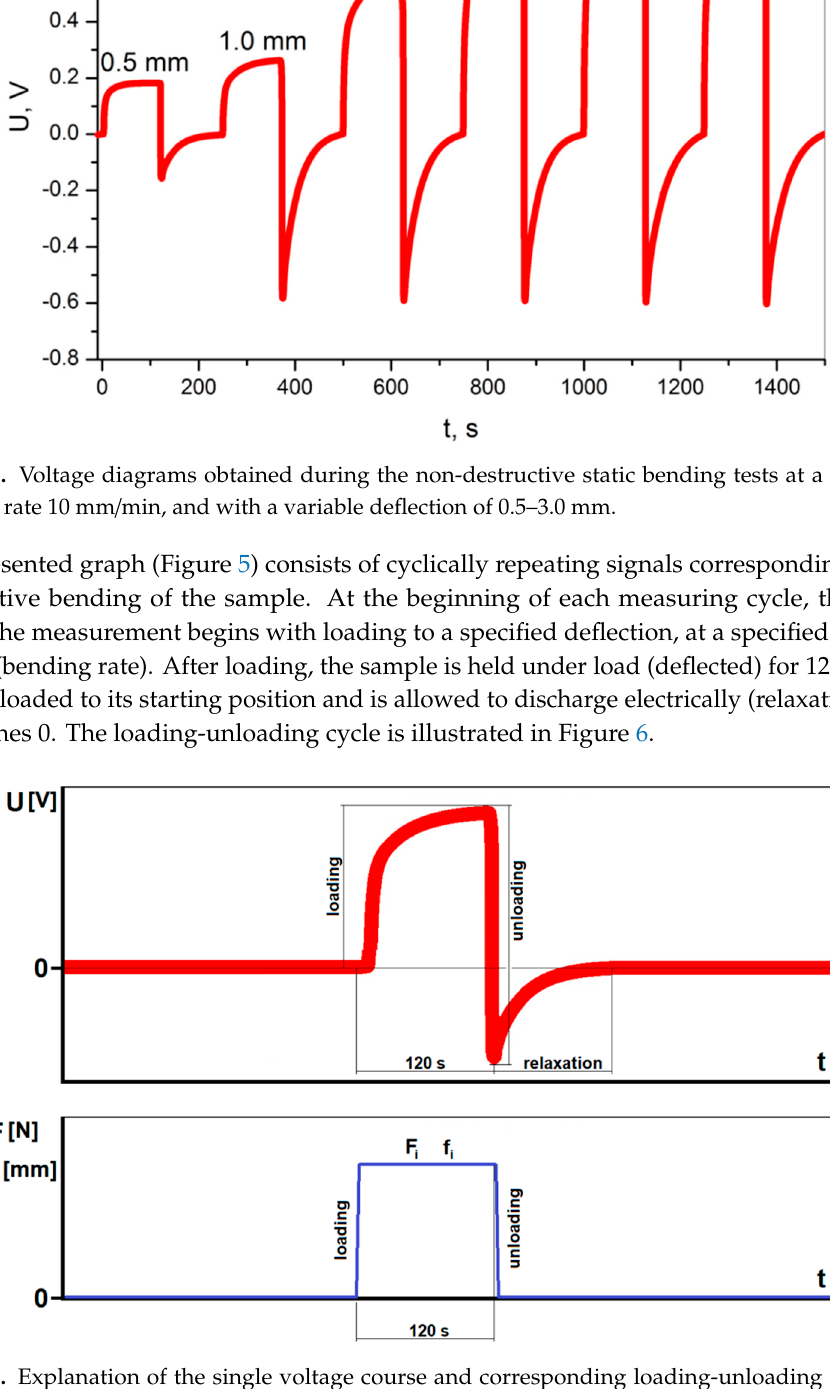
Figure 7. Voltage diagrams obtained during the non-destructive static bending tests at a constant deflection of 3.0 mm, with a variable bending rate of 1–500 mm/min. The obtained voltage results show 1.0 V for higher deformation at low speed (Figure 5) and about 1.5 V for high speeds (Figure 7), which are considered favorable for structural deformation